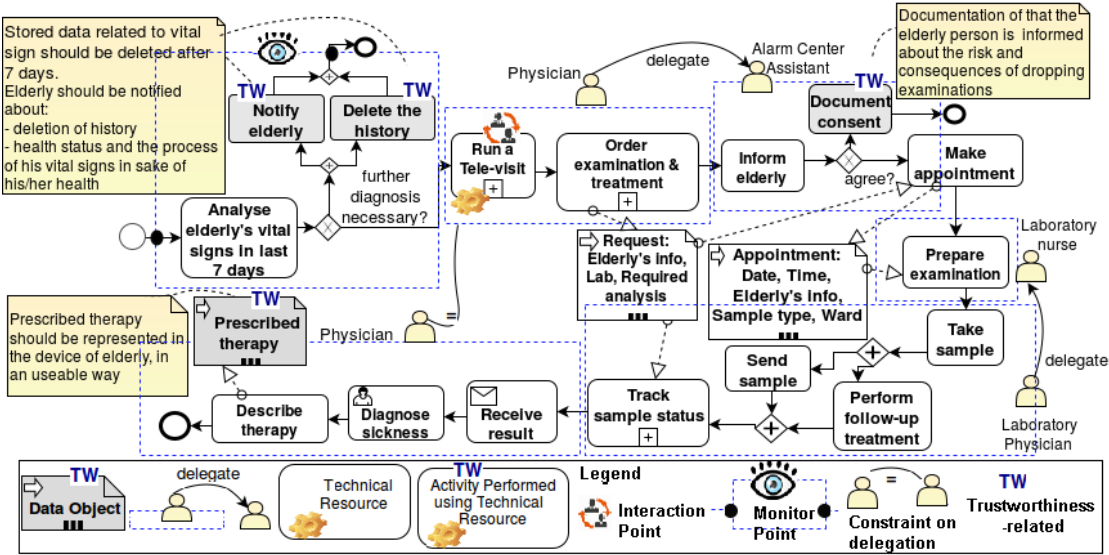
Figure 10. Exemplary business process model enriched with trustworthiness